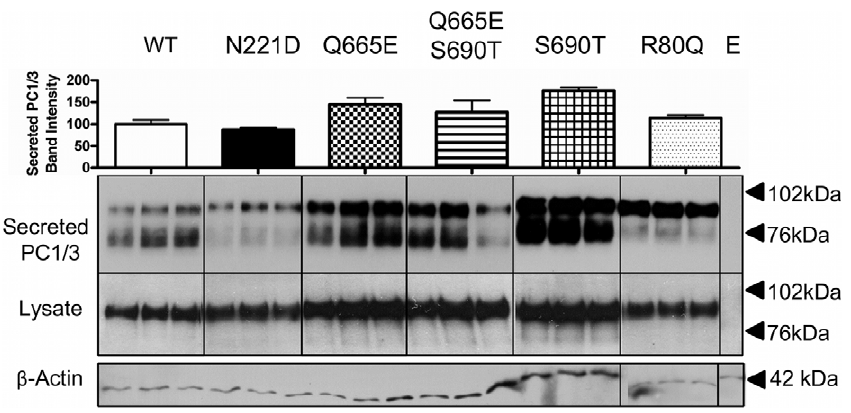
Figure 3. Western blotting of wild-type and variant PC1/3 proteins expressed in HEK cells. HEK cells were transiently transfected with empty pcDNA3 (E); pcDNA3 encoding either wild-type PC1/3; or PC1/3 proteins bearing the mutations under study. Western blots of cell lysates and media from transfected HEK cells were probed with amino-terminally directed PC1/3 primary antiserum for detection of recombinant proteins. The data shown represent 1 of 3 independent experiments performed in triplicate. Total secreted immunoreactive band intensity values, obtained through densitometry analysis and used to calculate specific activity for each variant, are represented above the Western blot and shown as the mean 6 S.D.